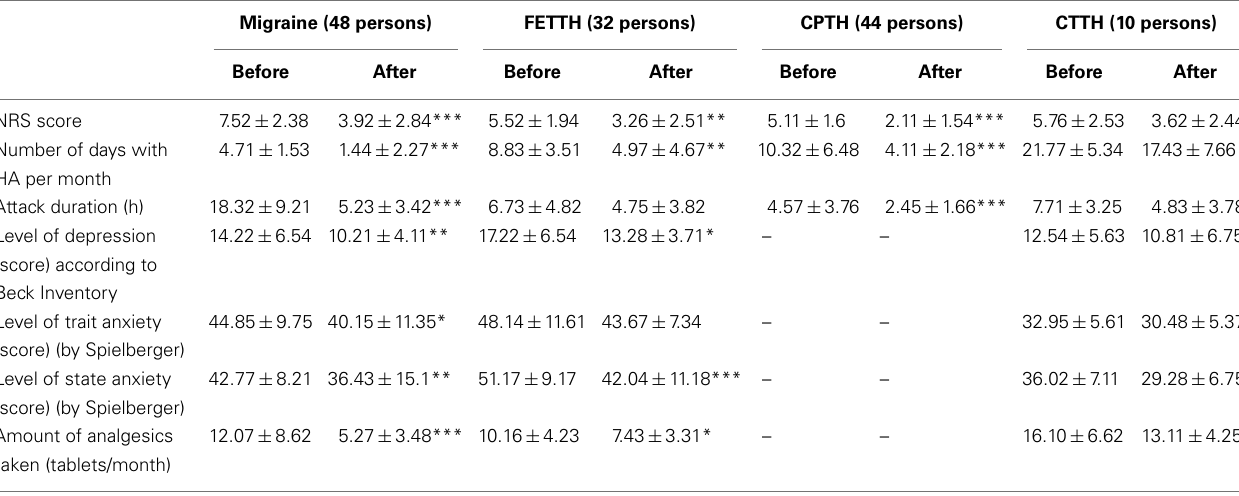
Table 1 | Results of tDCS treatment of various HA types (in analyzed groups in